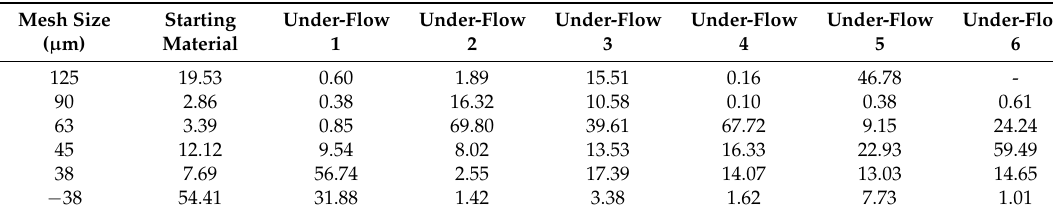
Table 2. Sieving results of hydrocyclone underflows in